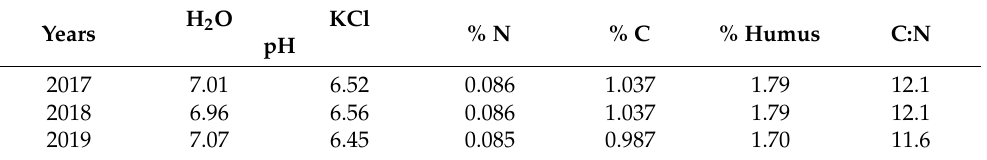
Table 1. Chemical properties of the experimental field during the growing seasons adapted from